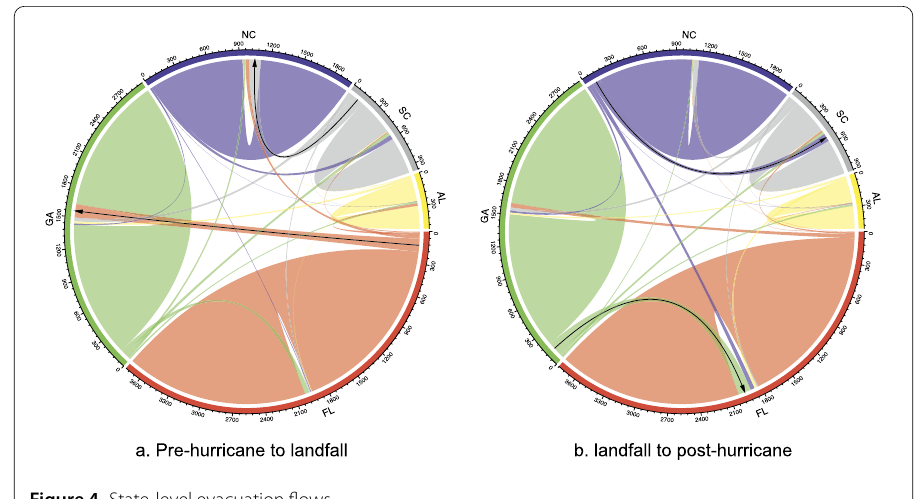
Figure 4 State-level evacuation